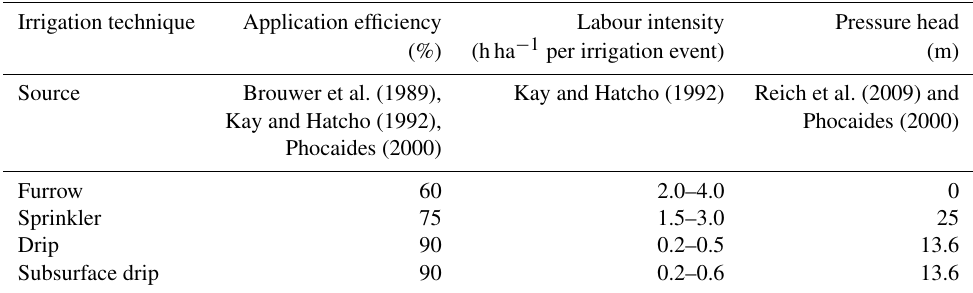
Table 1. The application efficiency, labour intensity and pressure head required per irrigation technique. Irrigation